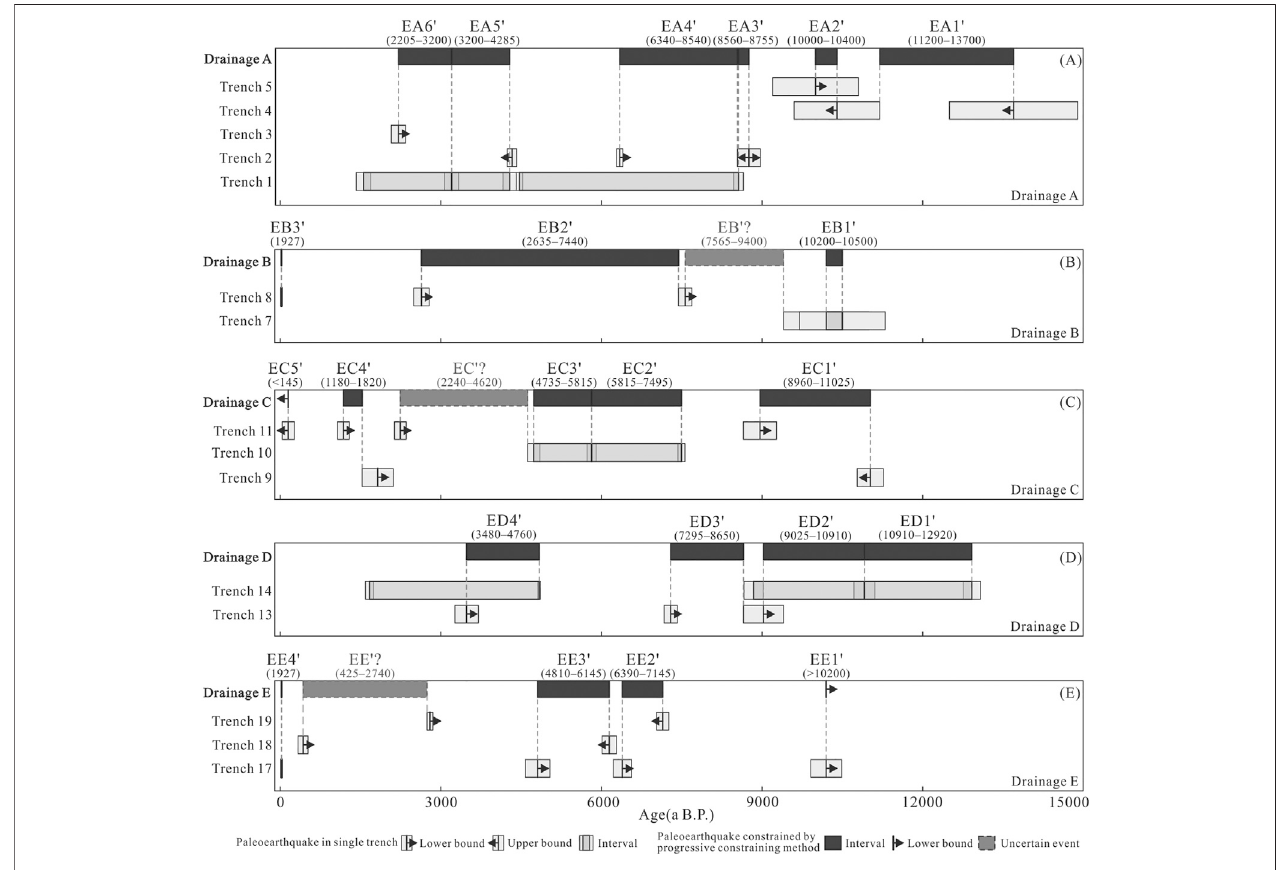
FIGURE5| Paleoearthquakesconstrainedbytheprogressiveconstrainingmethodin (A) DrainageA, (B) DrainageB, (C) DrainageC, (D) DrainageD,and (E) DrainageE.